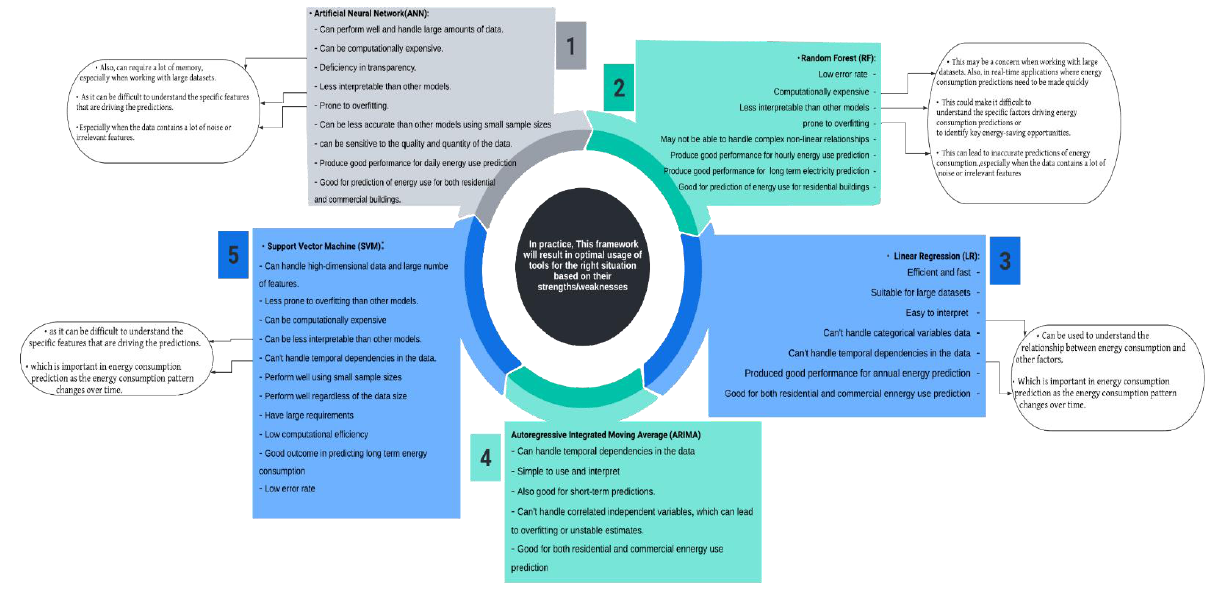
Figure 7. Proposed guideline for tool selection for energy consumption